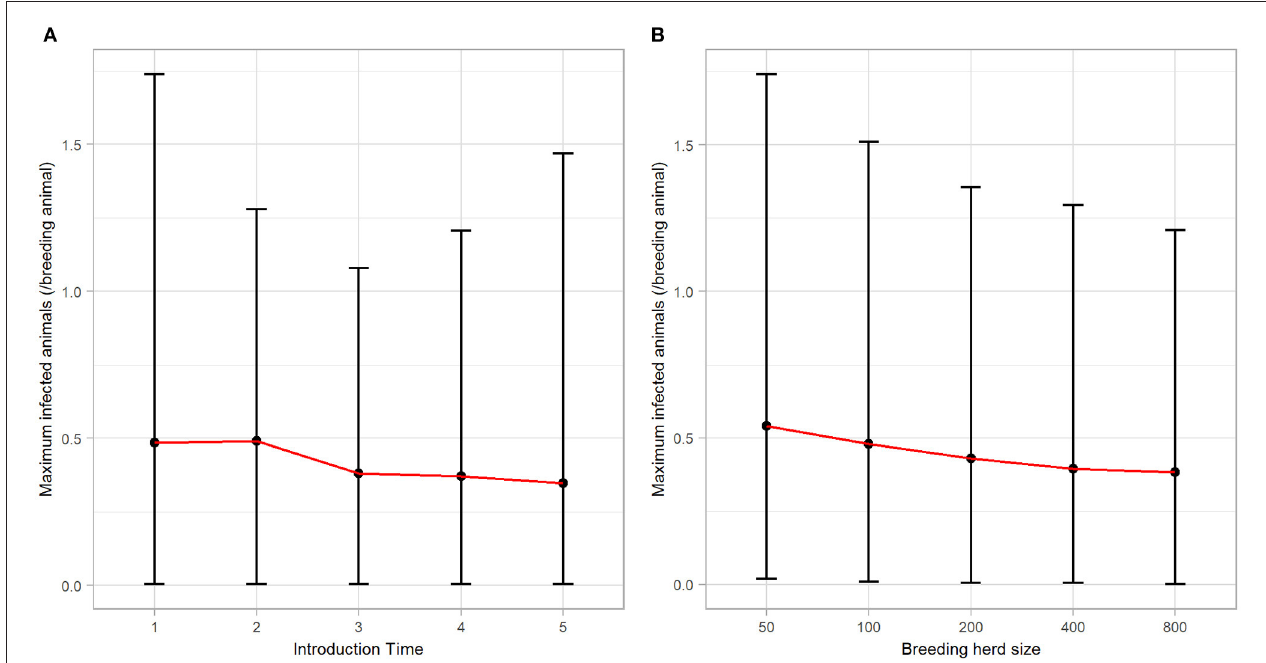
FIGURE 2 | The maximum annual BVDV infections following a single PI introduction in a simulated beef herd. Line plots illustrating the influence of (A) introduction time and (B) breeding herd size on the number of animals (per breeding animal) that became infected by BVDV in the highest year of BVDV transmission. Points represent the median value, while error bars represent the 95%